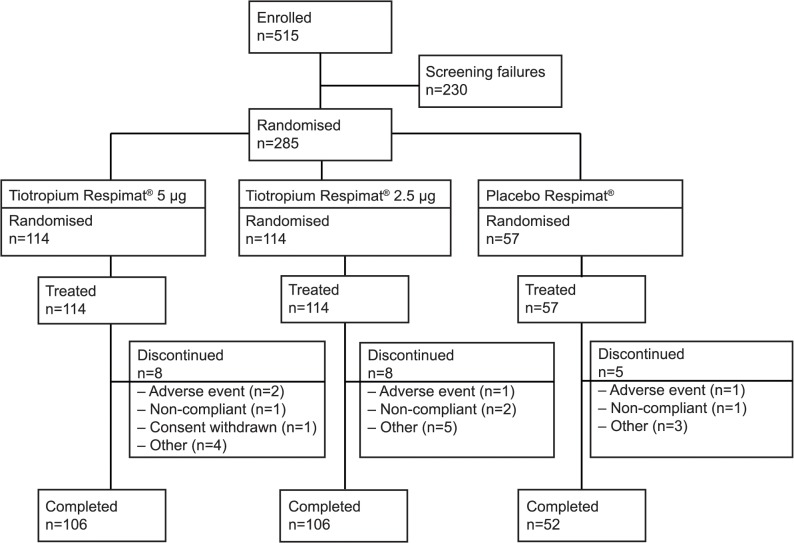
CONSORT diagram.